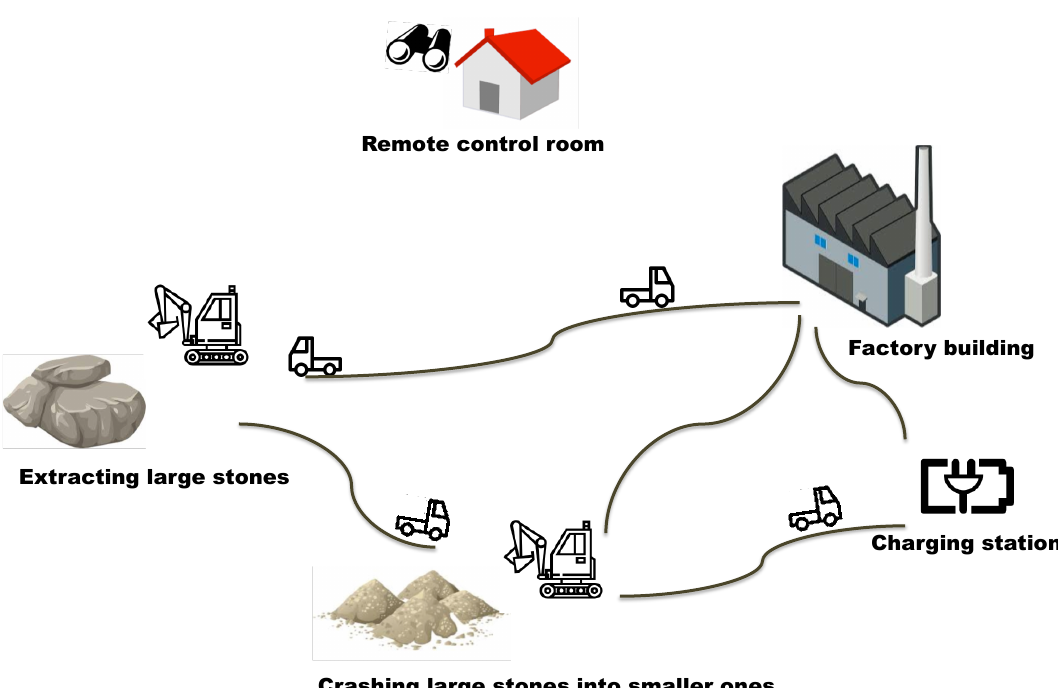
Figure 3. A running example of an autonomous